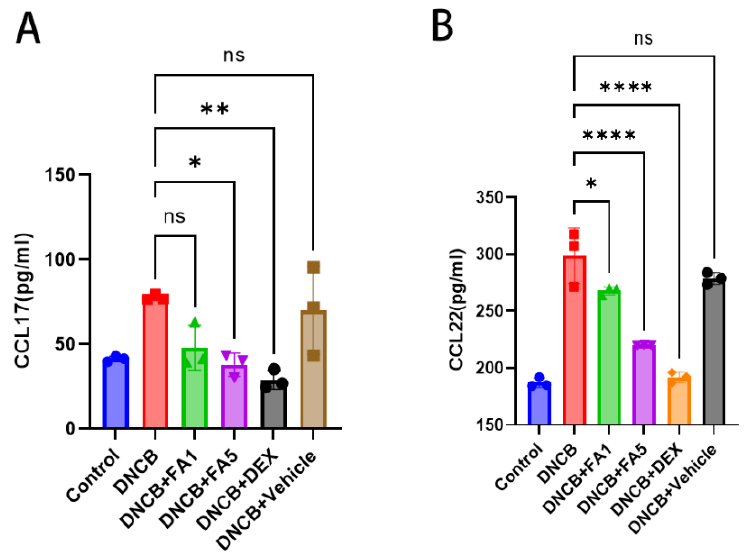
Figure 6. Effects of FA treatment on serum CCL17 and CCL22 levels . The concentrations of CCL17 ( A ) and CCL22 ( B ) in serum were measured using ELISA on day 15 of the study. A minimum of three experiments were used to calculate the mean ± SEM. **** p < 0.0001, ** p < 0.01, * p < 0.05, ns means not significant difference.